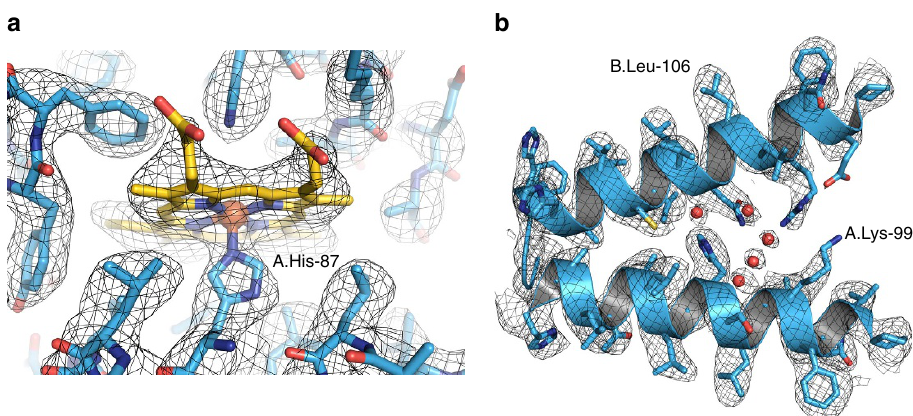
Figure 2 | Hgb at 3.2Å resolution. ( a ) The iron atom of the prosthetic haem group is coordinated by the proximal histidine residue, as evidenced by a strong density connecting them. ( b ) Side-chain details and putative water molecules in the 3D electron scattering potential map (red spheres).